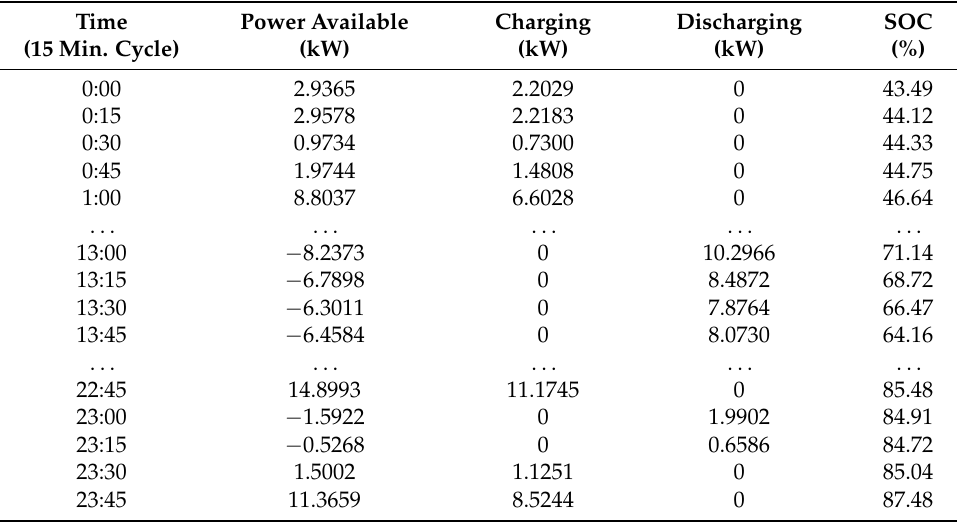
Figure 17. State of charge of Street Battery in Cloudy day. Table 9. Power available, Charging, Discharging and SOC values in